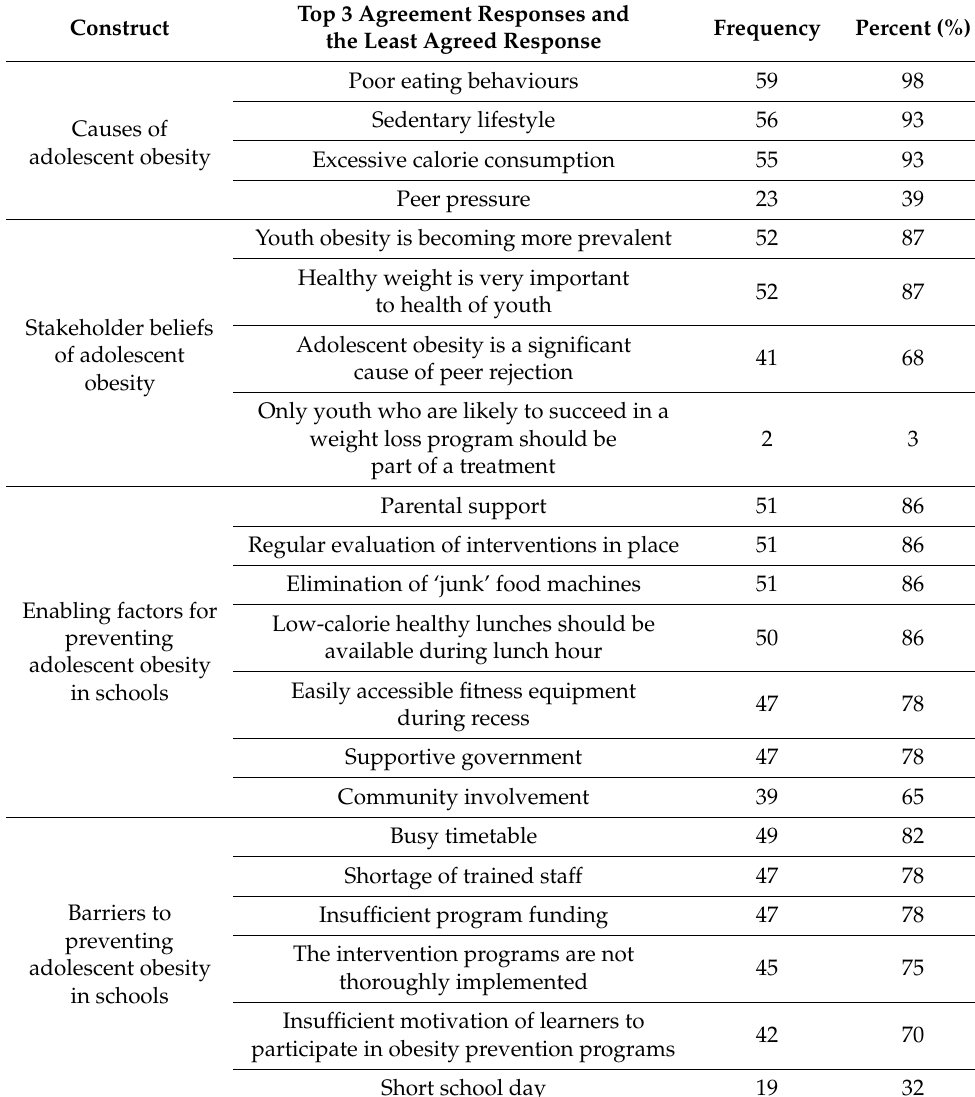
Table 2. Queensland school stakeholders’ perceptions and beliefs of the causes, enabling and hindering factors of adolescent obesity ( n =